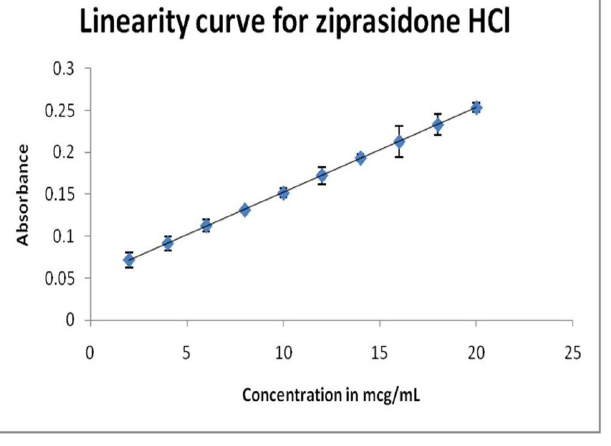
FIGURE 2 - Linearity curve for Ziprasidone